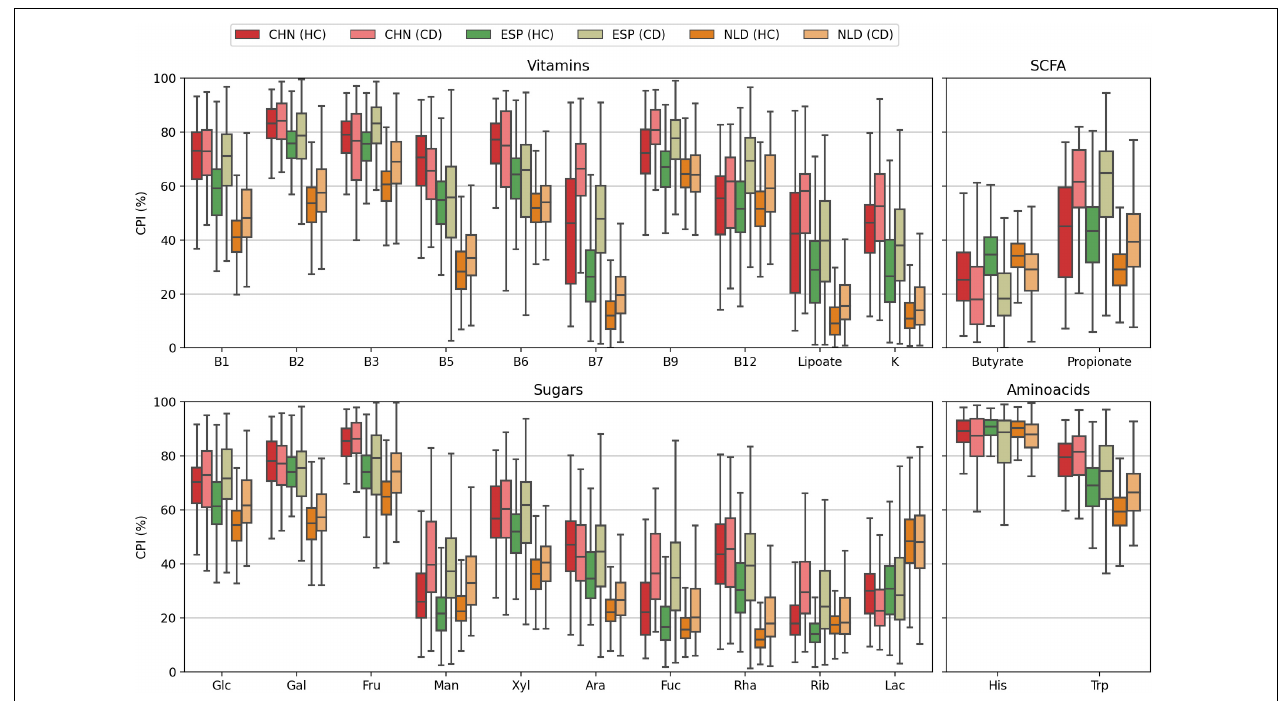
FIGURE 8 | Distributions of the CPI values calculated for samples from heathy (HC) and Crohn’s diseases (CD) cohorts in the CHN, ESP, and NLS